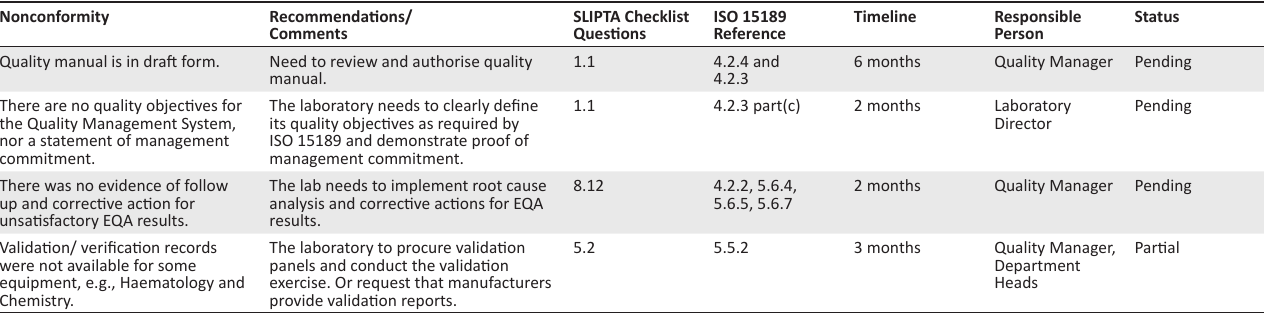
TABLE 2: Example of quality systems implementation plan. Nonconformity